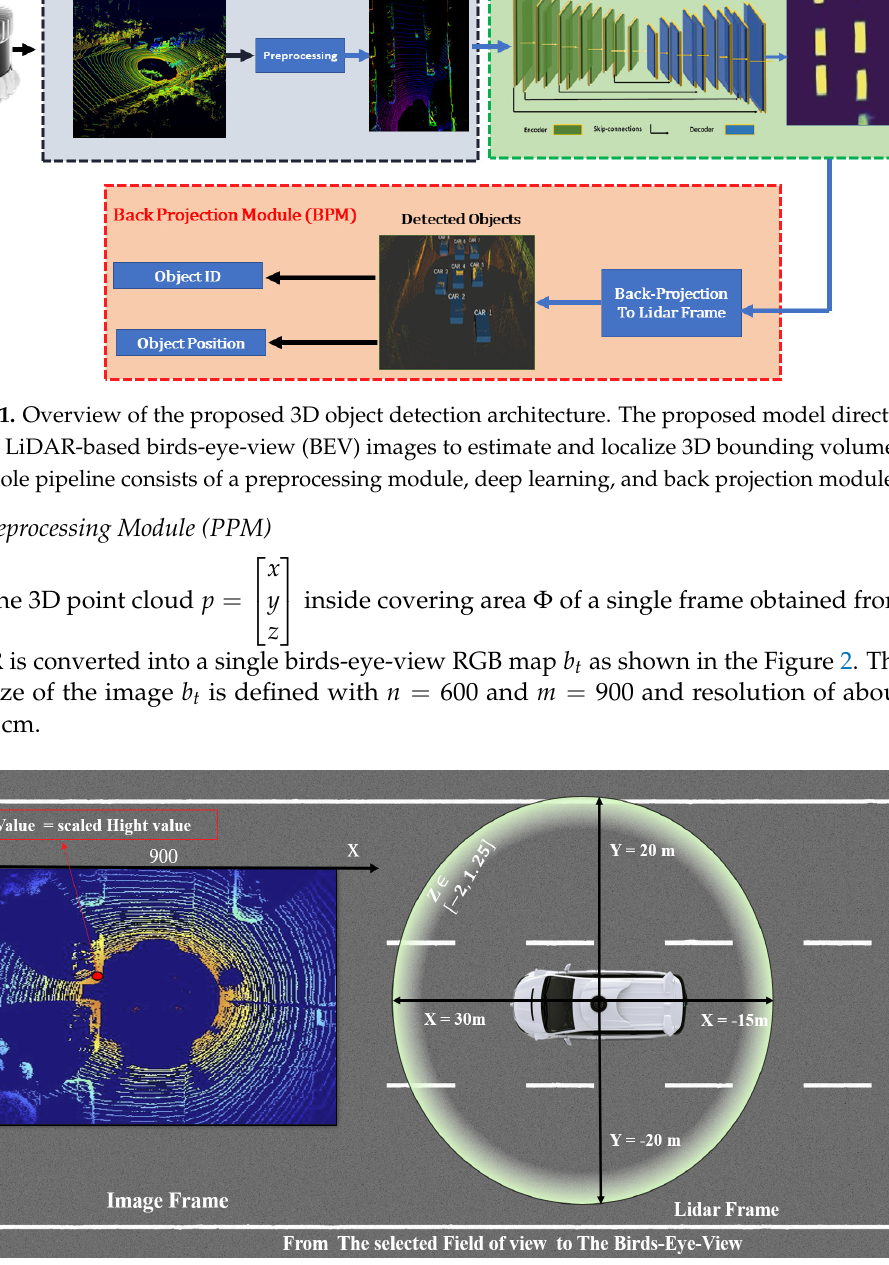
Figure 2. Schematic representation of the birds-eye-view RGB